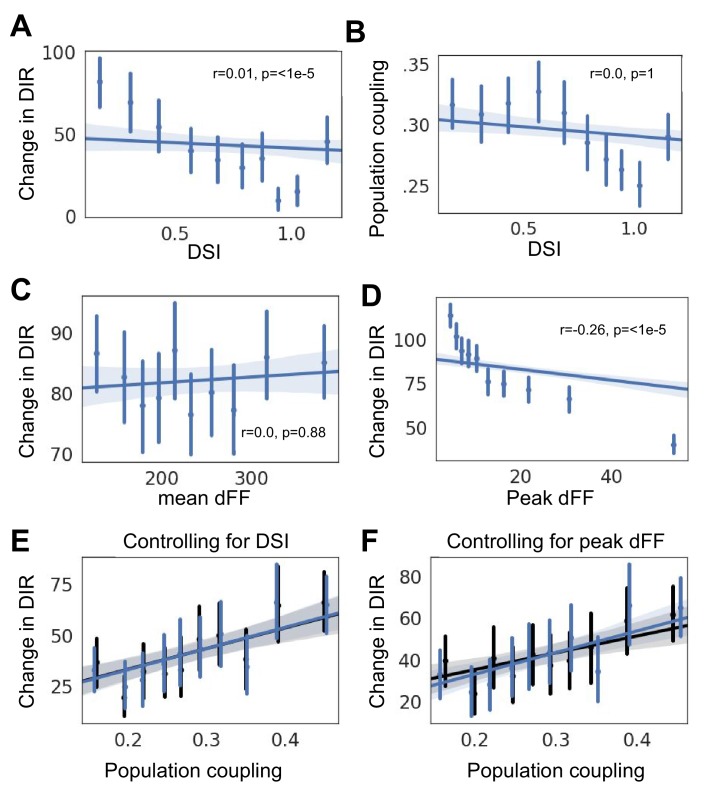
Potentially confounding factor.(A) Changes in direction selectivity versus direction selectivity index (DSI). (B) Population coupling versus direction selectivity index (DSI). (C) Changes in direction selectivity versus mean calcium fluorescence. (D) Changes in direction selectivity versus peak calcium fluorescence. (E) Relationship between population coupling and Δ⁢DIRpref (blue), and when DSI is regressed out as a potentially confounding factor (black). (F) Relationship between population coupling and Δ⁢DIRpref (blue), and when peak calcium fluorescence is regressed out as a potentially confounding factor (black).